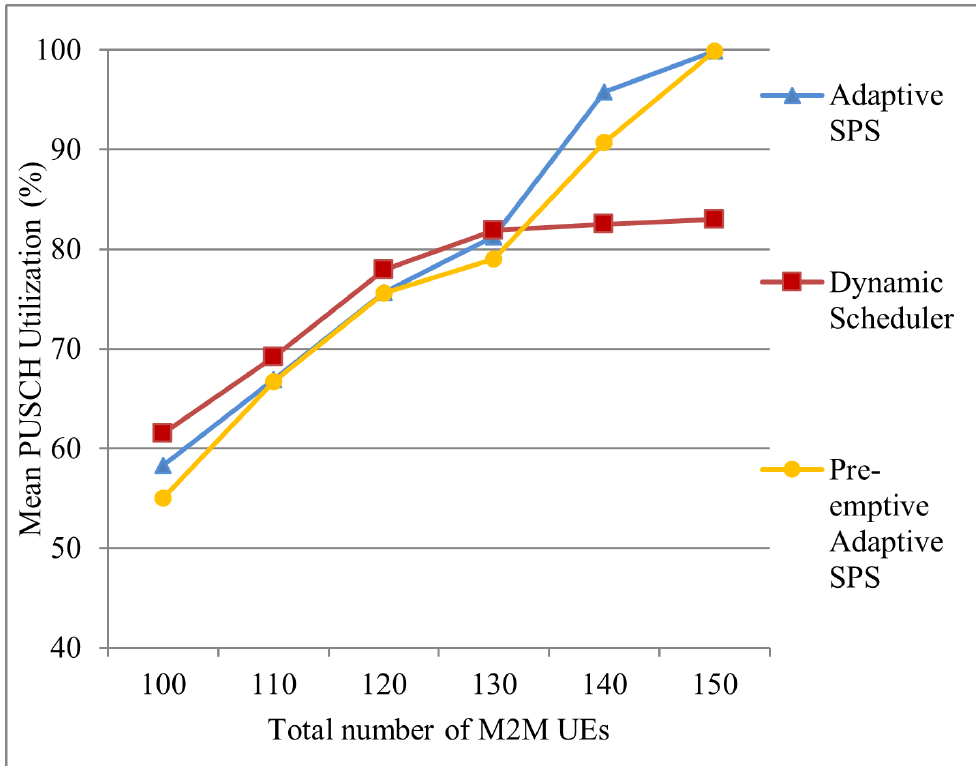
Figure 17. Mean data channel utilization with increasing number of